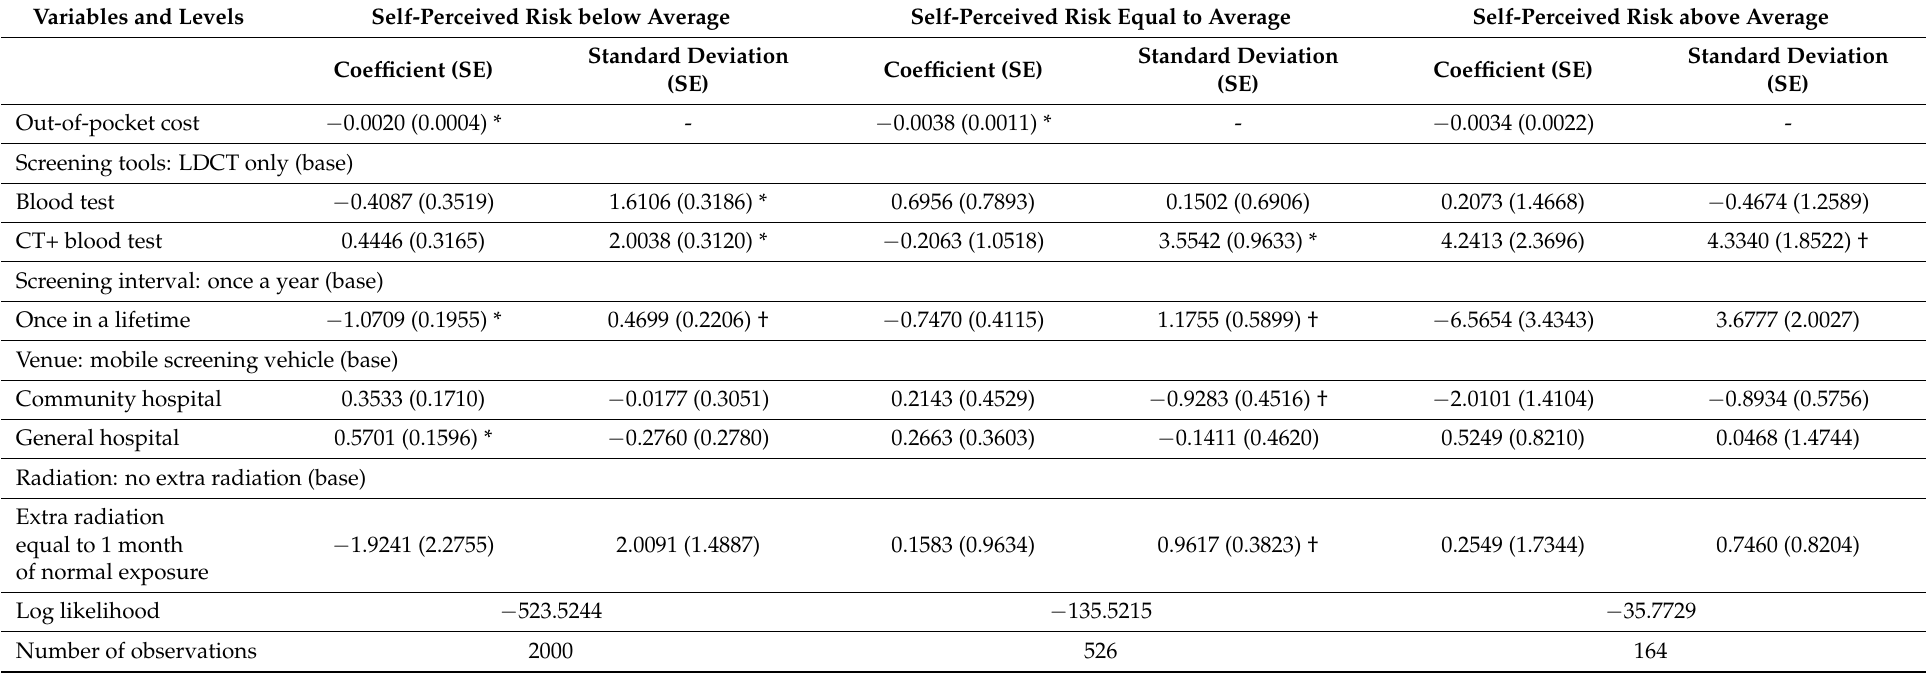
Table 4. Results of mixed logit analysis (different self-perceived risk